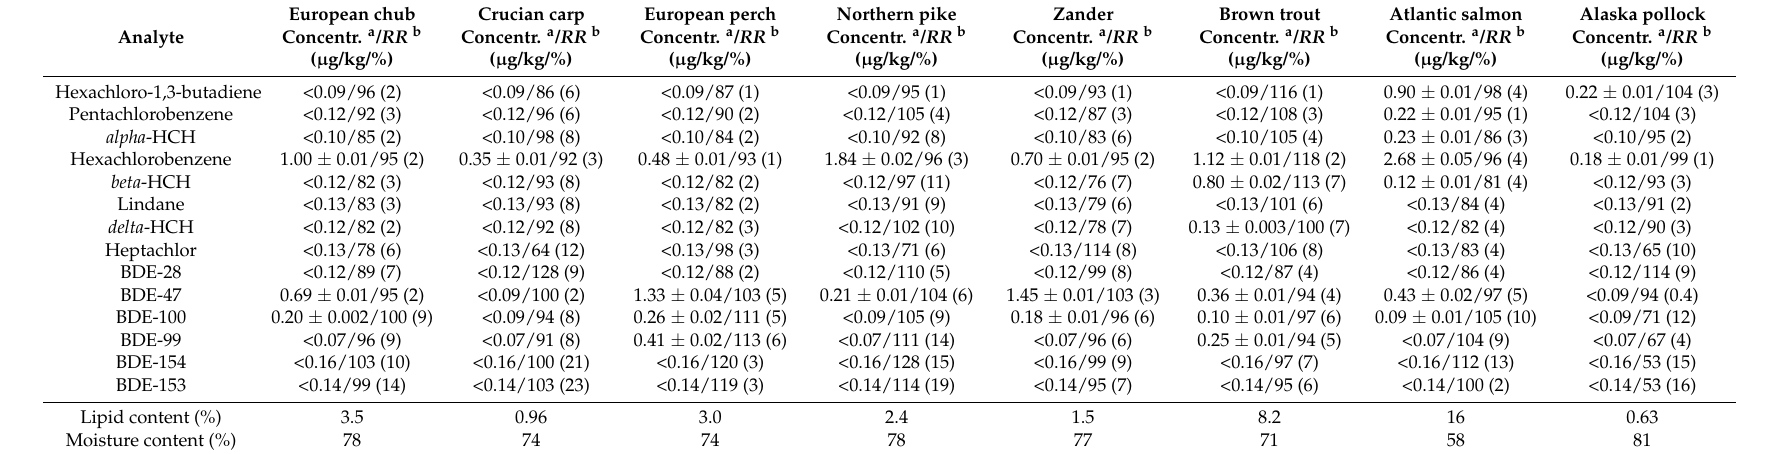
Table 7. Analysis of samples of different fish